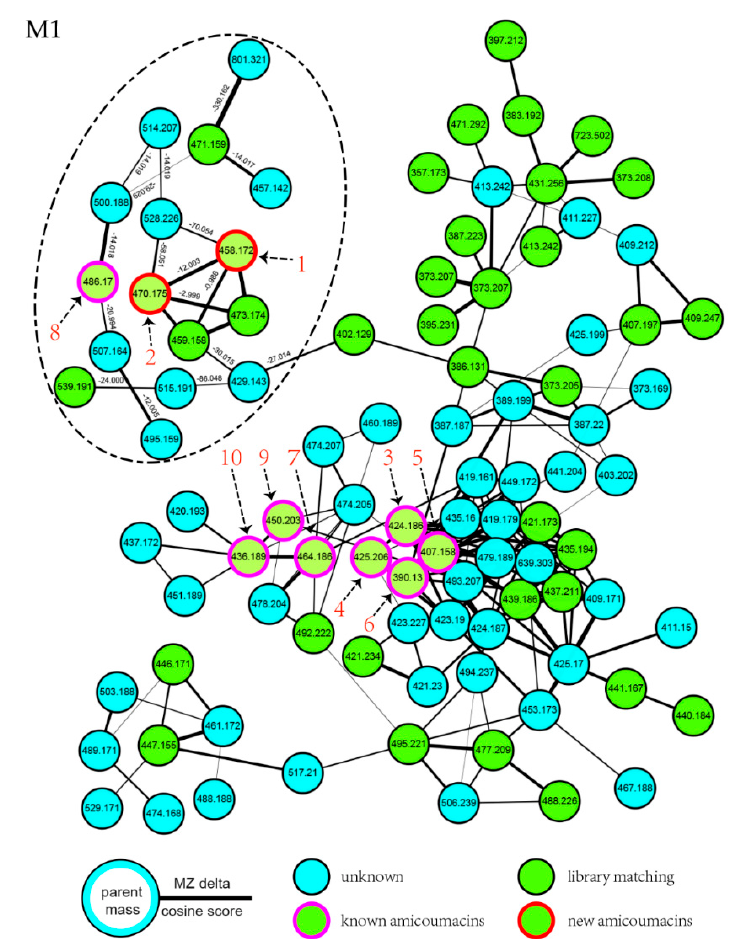
Figure 2. Molecular networking for the targeted fraction from the extract of B. subtilis PJS, contributing to the dereplication of known amicoumacins and directed discovery of new amicoumacin analogs ( 1 and 2 ). In the network, the experimental data of strain PJS extract nodes are represented by blue circles; nodes that are a consensus of experimental data and database information are shown as green circles; the nodes identified to be known amicoumacins are shown as green circles with magenta outer; and the nodes putative to be new amicoumacin analogs are shown as green circles with red outer.